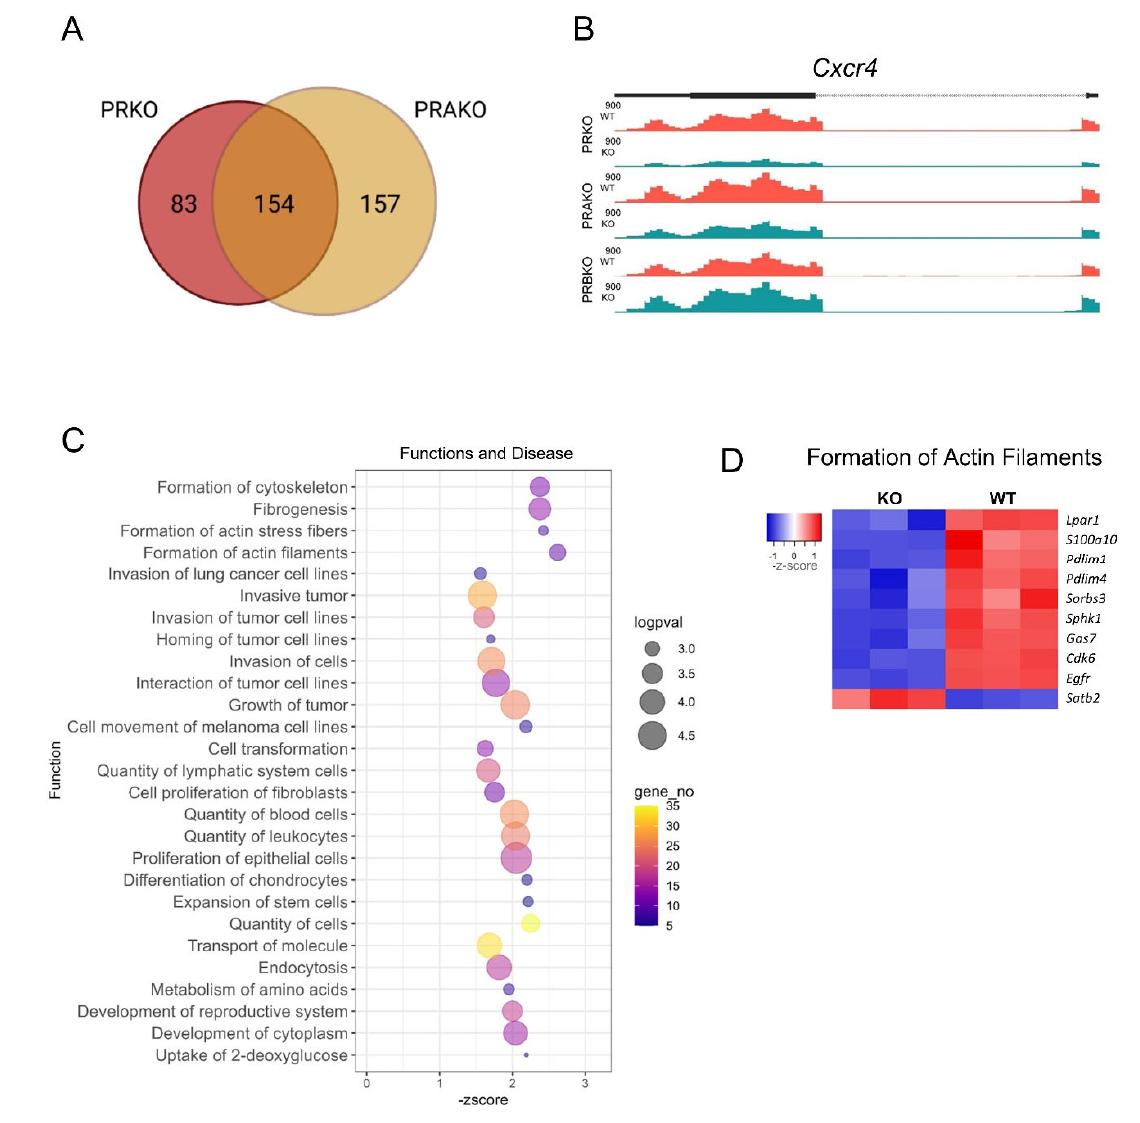
Figure 6. RNA-seq of PRKO, PRAKO and PRBKO granulosa cells identifies PGR-regulated genes and pathways. RNA-seq was performed on WT and KO granulosa cells of the PRKO, PRAKO and PRBKO strains. ( A ) RNA-seq analysis identified 236 DEGs in PRKO GCs and 310 for PRAKO GCs with 154 common DEGs (logFC ≥ 1, padj ≤ 0.01). ( B ) Example of mapped RNA-seq reads for PRKO, PRAKO and PRBKO depicting genome site for Cxcr4 . ( C ) The 154 DEGs common to PRKO and PRAKO were analyzed in IPA and most highly downregulated function and diseases identified, depicted with log p -value (size), the number of DEGs associated with the function (color) and z-score indicating degree of downregulation ( X -axis). Functions are grouped based on similarities. ( D ) Heatmap depicting the DEGs associated with “formation of actin filaments” function. RNA-seq reads per samples (log-counts per million, LCPM) are shown for PRKO (left) and PRWT (right) where blue is low and red is high expression.